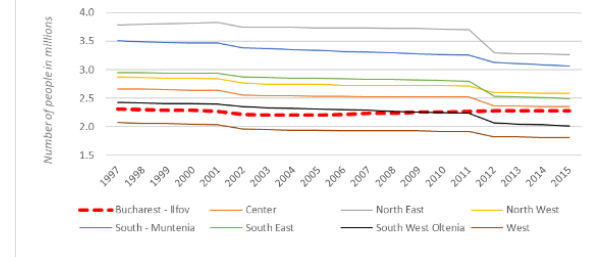
Figure 2 . Evolution of resident population within the 8 development regions between 1997-2015 (data source: NIS 2022)